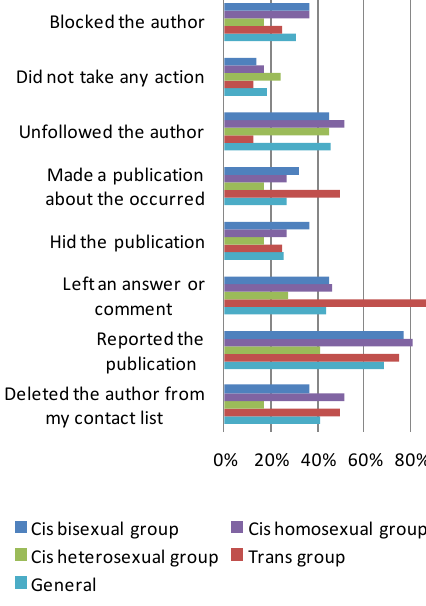
Fig. 4 – Percentage of response actions taken by each